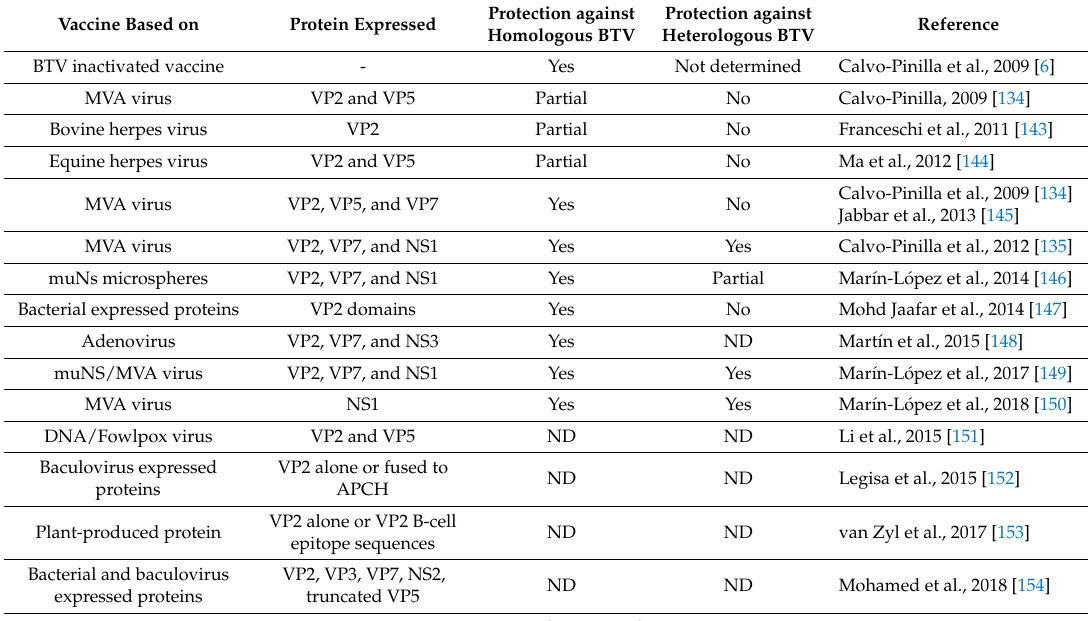
Protection against Protection against Reference Homologous BTV Heterologous BTV